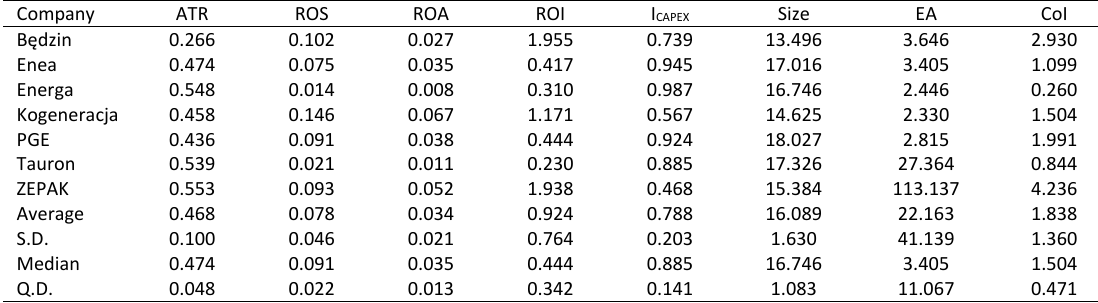
Table 5: Financial and environmental ratios for Polish energy groups in 2016 Company ATR ROS ROA ROI I CAPEX Będzin